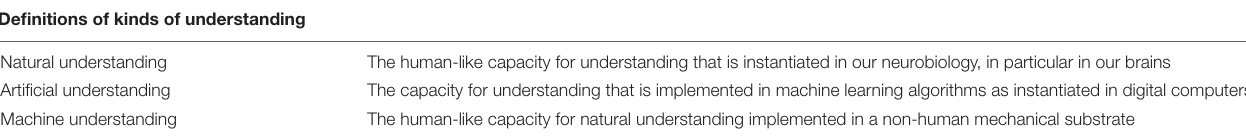
TABLE 1 | Definitions of the three kinds of understanding referred to in this article.